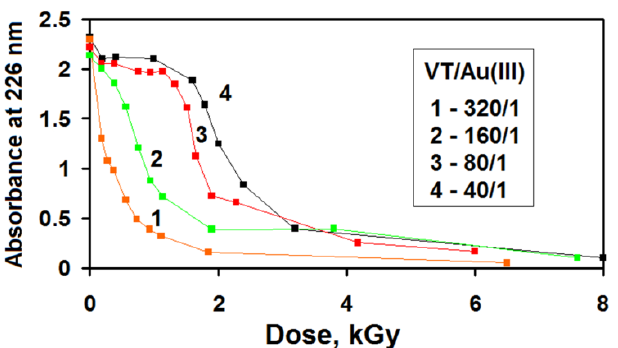
Figure 6. The dose-dependences of the optical density at λ = 226 of the irradiated VT–Au(III) solutions with various ratios of VT to Au(III) (diluted by a factor of 50). Table 2. The effect of the Au(III) concentration on the kinetics of polymerization of 1-vinyl-1,2,4-triazole.